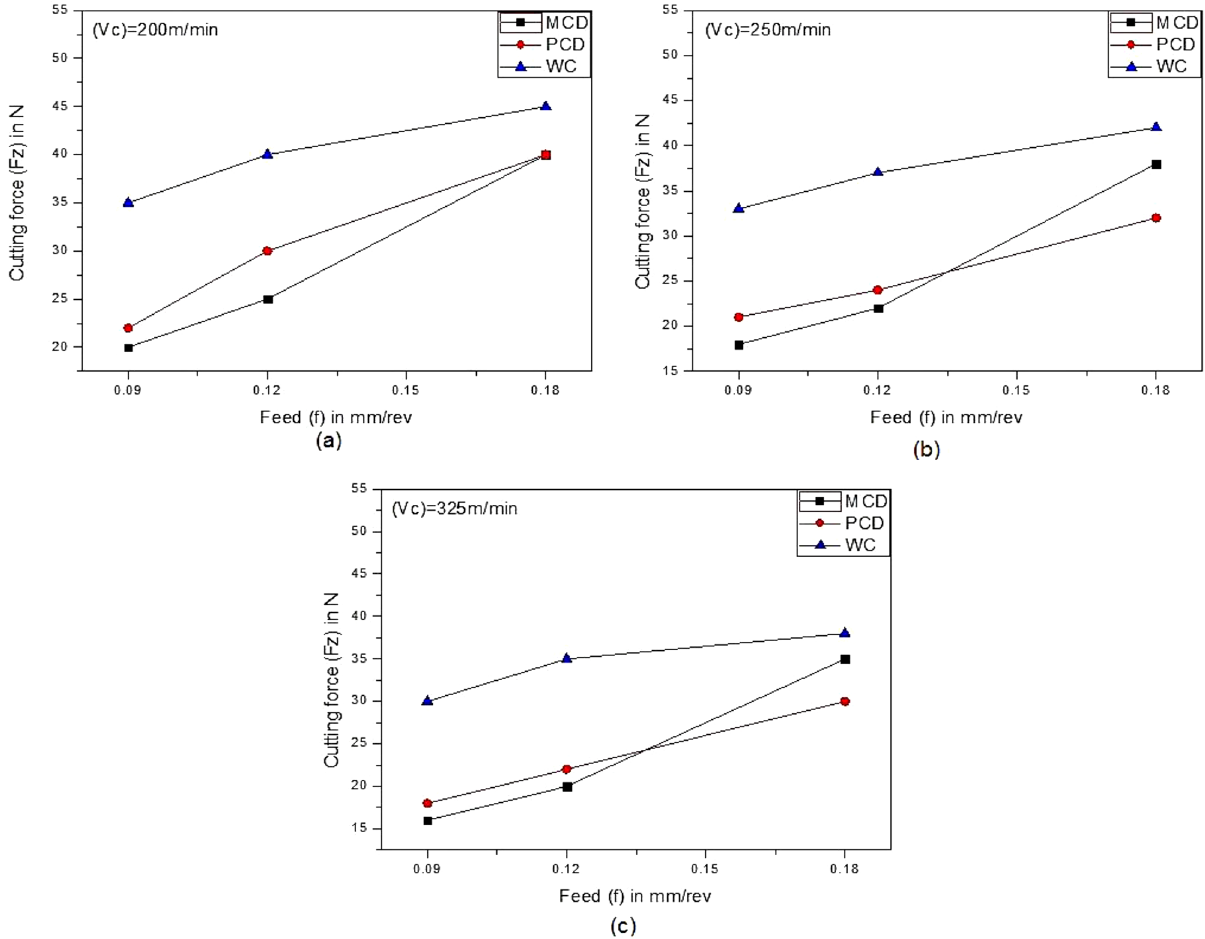
Fig. 14. Graph representing the cutting force values at various feed 0.09 mm/rev, 0.12 mm/rev and 0.18 mm/red with constant cutting speed (a) 200m/min, (b) 250 m/min and (c) 325m/min